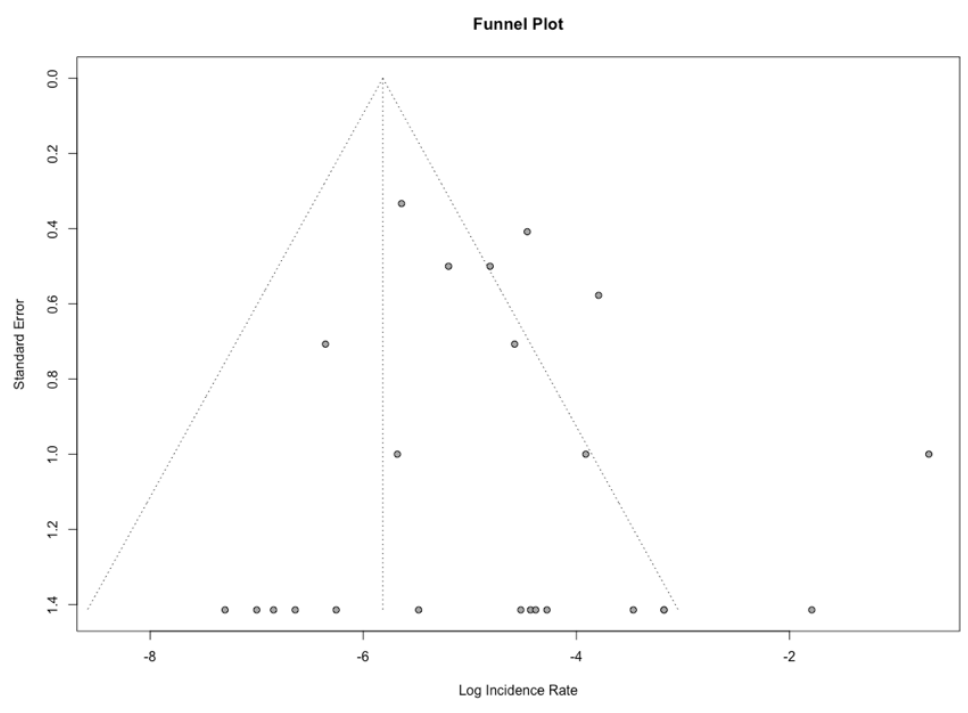
Figure 3. Funnel plot for the assessment of publication bias.